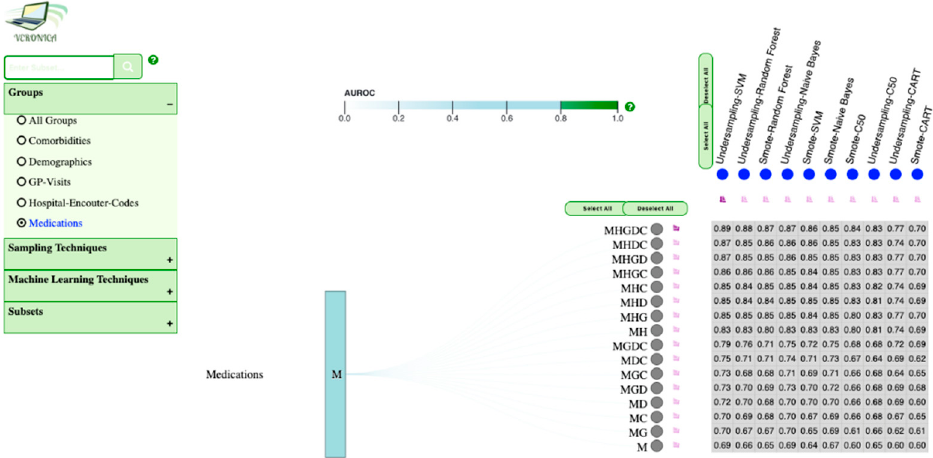
Figure 7. How the system gets updated when users select “Medications” from the “Groups” drop-down menu.